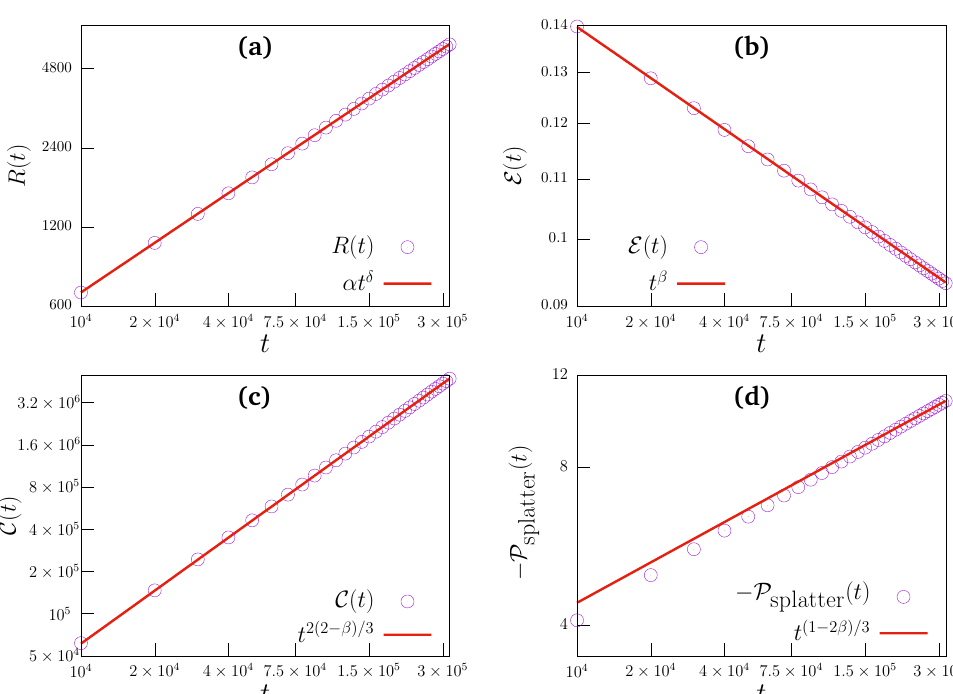
Figure 3: Comparison of microscopic simulation results (points) with analytic pre- dictions (solid lines) for the time-dependence of various observables: (a) The shock position R ( t ) , evaluated from simulations as the average position of the rightmost moving particle at time t . The slope of the solid line R ( t ) = α t δ , was found to be α = 2.08; (b) total energy of the particles E( t ) in x > 0 region; (c) total number of collisions C( t ) ; (d) total momentum P splatter ( t ) in the x < 0 region. The par- ticles are distributed uniformly with density ρ ∞ = 1, v 0 = 1, and the results are all shown for the mass arrangement (3a), with m = 2 / 3, M = 4 / 3. Averages over 2 × 10 5 realizations were done. In all cases the value of β given by Eq. (26) was used and δ β = ( 2 − )/